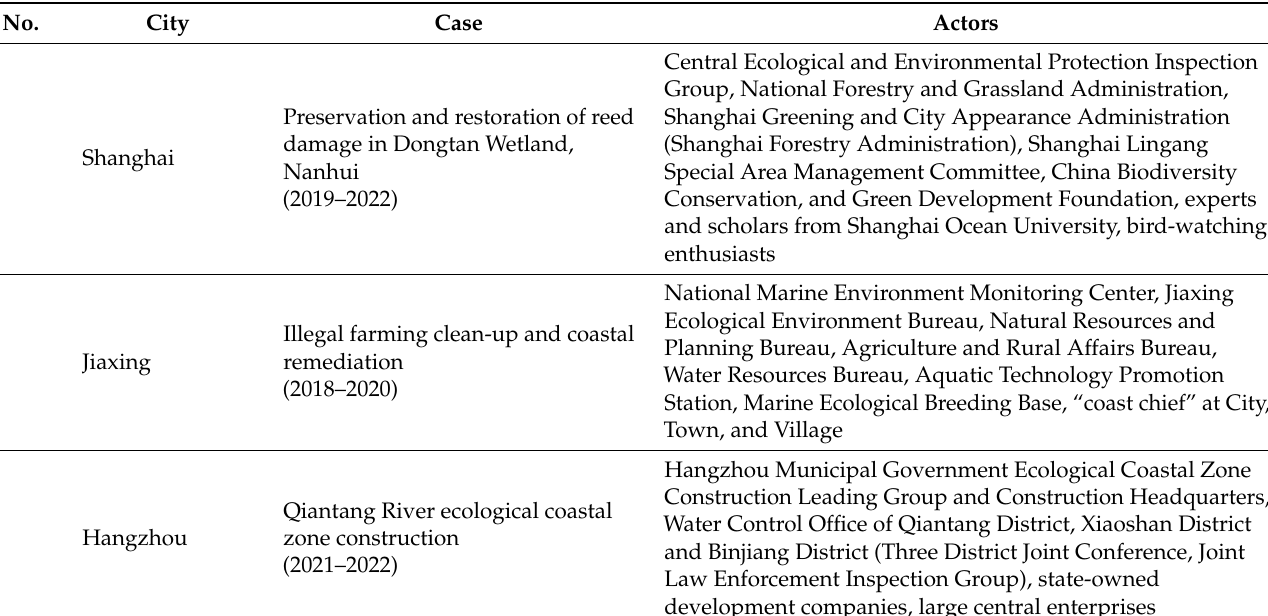
Table 2. Basic information of the cases studied to assess the construction of environmental collabora- tive governance relationship in the East China Sea coastal